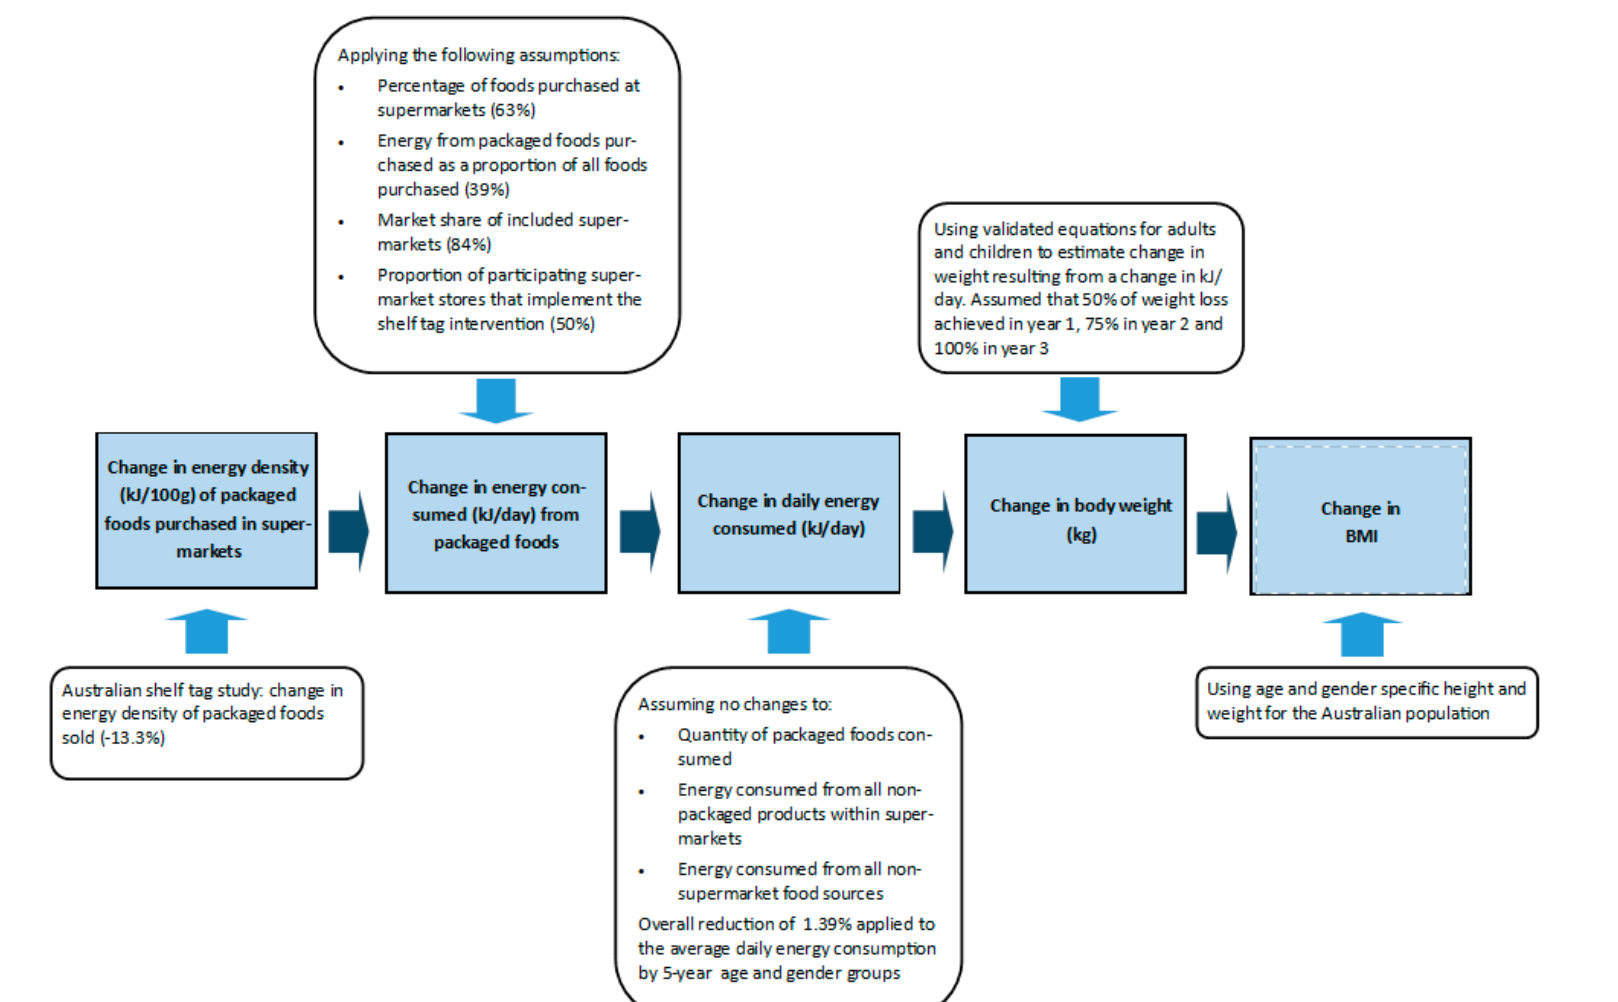
Figure 1. Logic pathway of intervention effect on average population weight and body mass index. Notes: BMI: body mass index; g: grams; kg: kilogram; kJ: kilojoules.